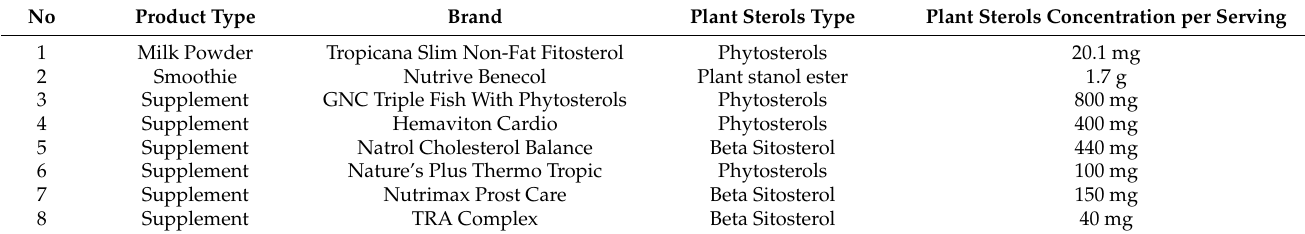
Table 5. List of products fortified with plant sterols available in the Bogor